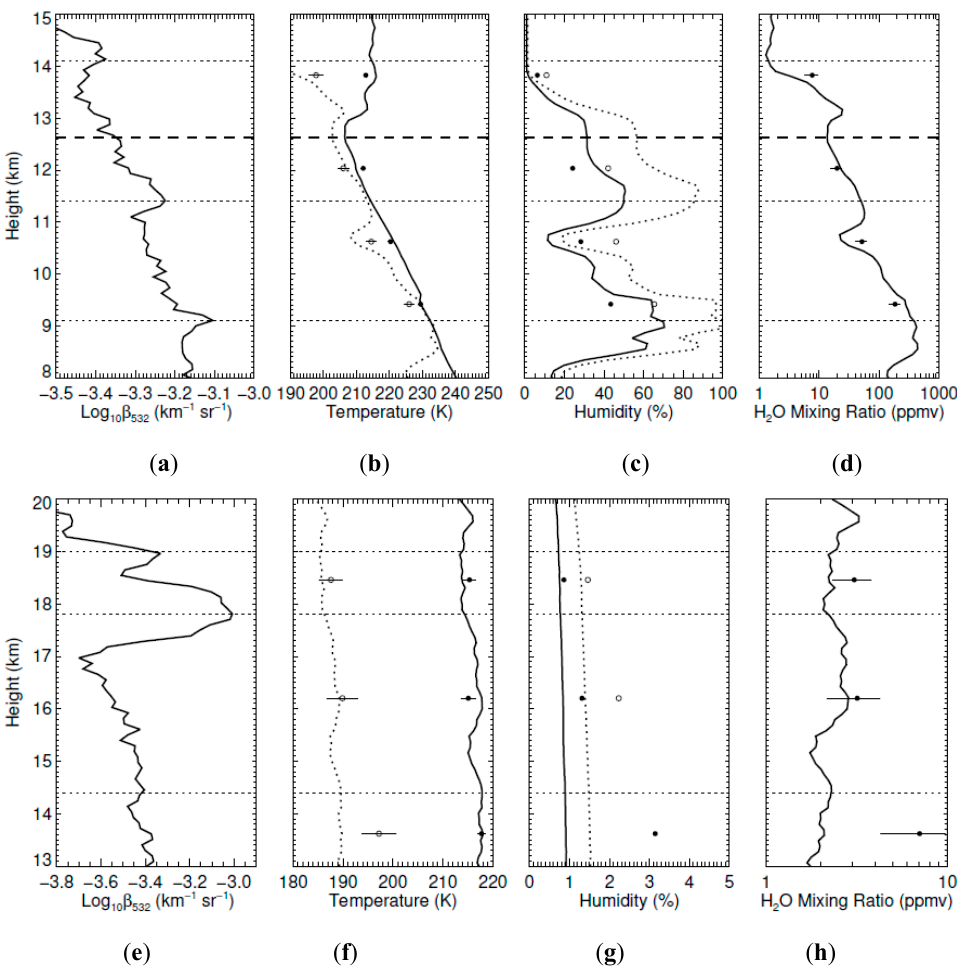
Figure 11. Similar to Figure 9, but for comparisons of Kingston lidar, radiosonde and AIRS measurements for 17 May (panels ( a ) to ( d )) and 22 May (panels ( e ) to ( h )) 2015. The radiosondes were launched from Hobart Airport, approximately 25 km from the lidar site. The separation of the radiosonde measurements from the lidar measurements in distance (bearing) and time was as follows; 17 May at 12 km height: 45 km (ENE), +3.2 h (for panels ( b ) to ( d )); 22 May at 18 km height: 92 km (NE), +4.3 h (for panels ( f ) to ( h )). The associated AIRS measurements were obtained on 17 May at 04:34 UT, 26 km NNW of Kingston (for panels ( b ) to ( d )), and 22 May at 04:52 UT, 29 km WSW of Kingston (for panels ( f ) to ( h )). The vertical resolution is 200 m.